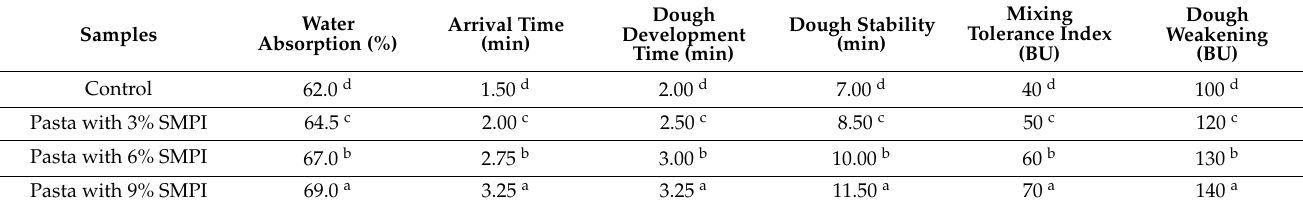
Table 2. Effect of mixing SMPI with wheat flour on farinograph parameters.